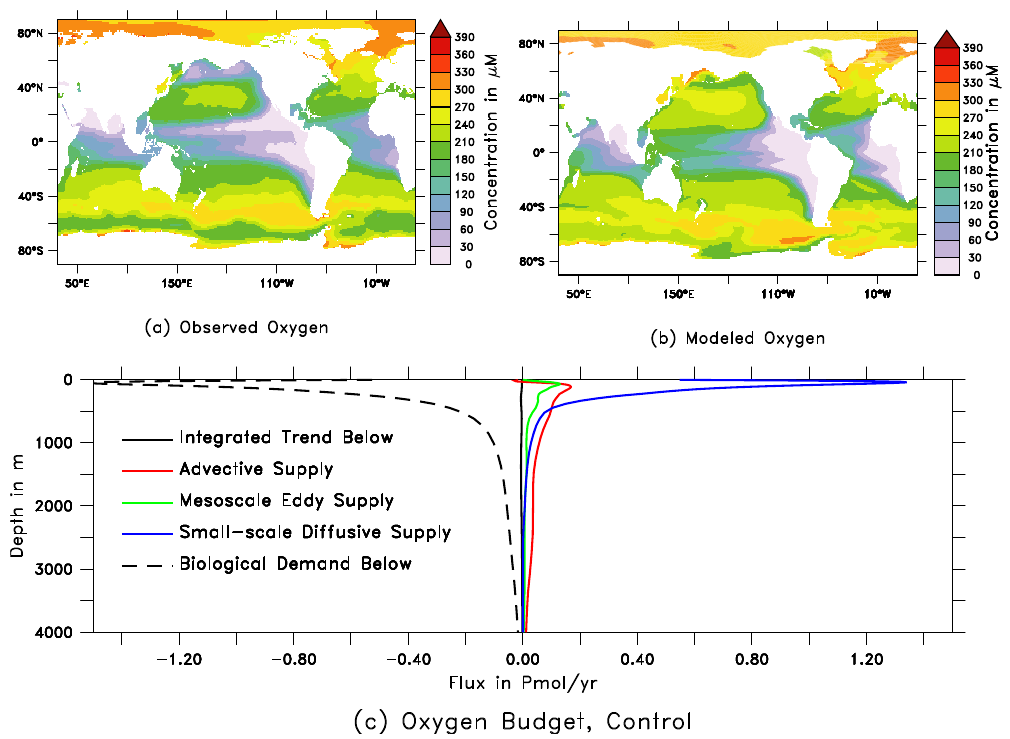
Fig. 1. Current dissolved oxygen distribution and budget. (a) Observed O 2 in µM at 300m. (b) Modeled O 2 in µM at 300m. (c) Vertically resolved budget of O 2 in 1860 Control simulation. Time shown is years 221–240, corresponding to years 1981–2000 historical run. Solid black line is the integrated trend of O 2 below a given depth-near-zero values show that the model is essentially in steady state. Red, green and blue lines show the supply of O 2 to deeper waters (corresponding to the downward flux) associated with advection, mesoscale eddy fluxes, and small-scale diffusion respectively. Dashed black line shows the net biological source/sink of O 2 below a given depth. The sum of the supply lines and source equals the